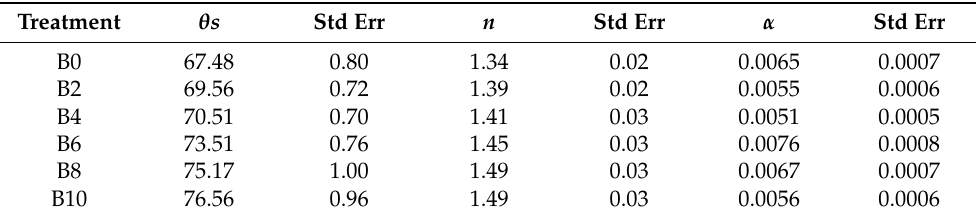
Table 6. Estimates of the van Genuchten model parameters to the six soil–biochar mixtures (treat- ments) without the clustering operations applied in the stepwise approach. (Compare Table 6 with